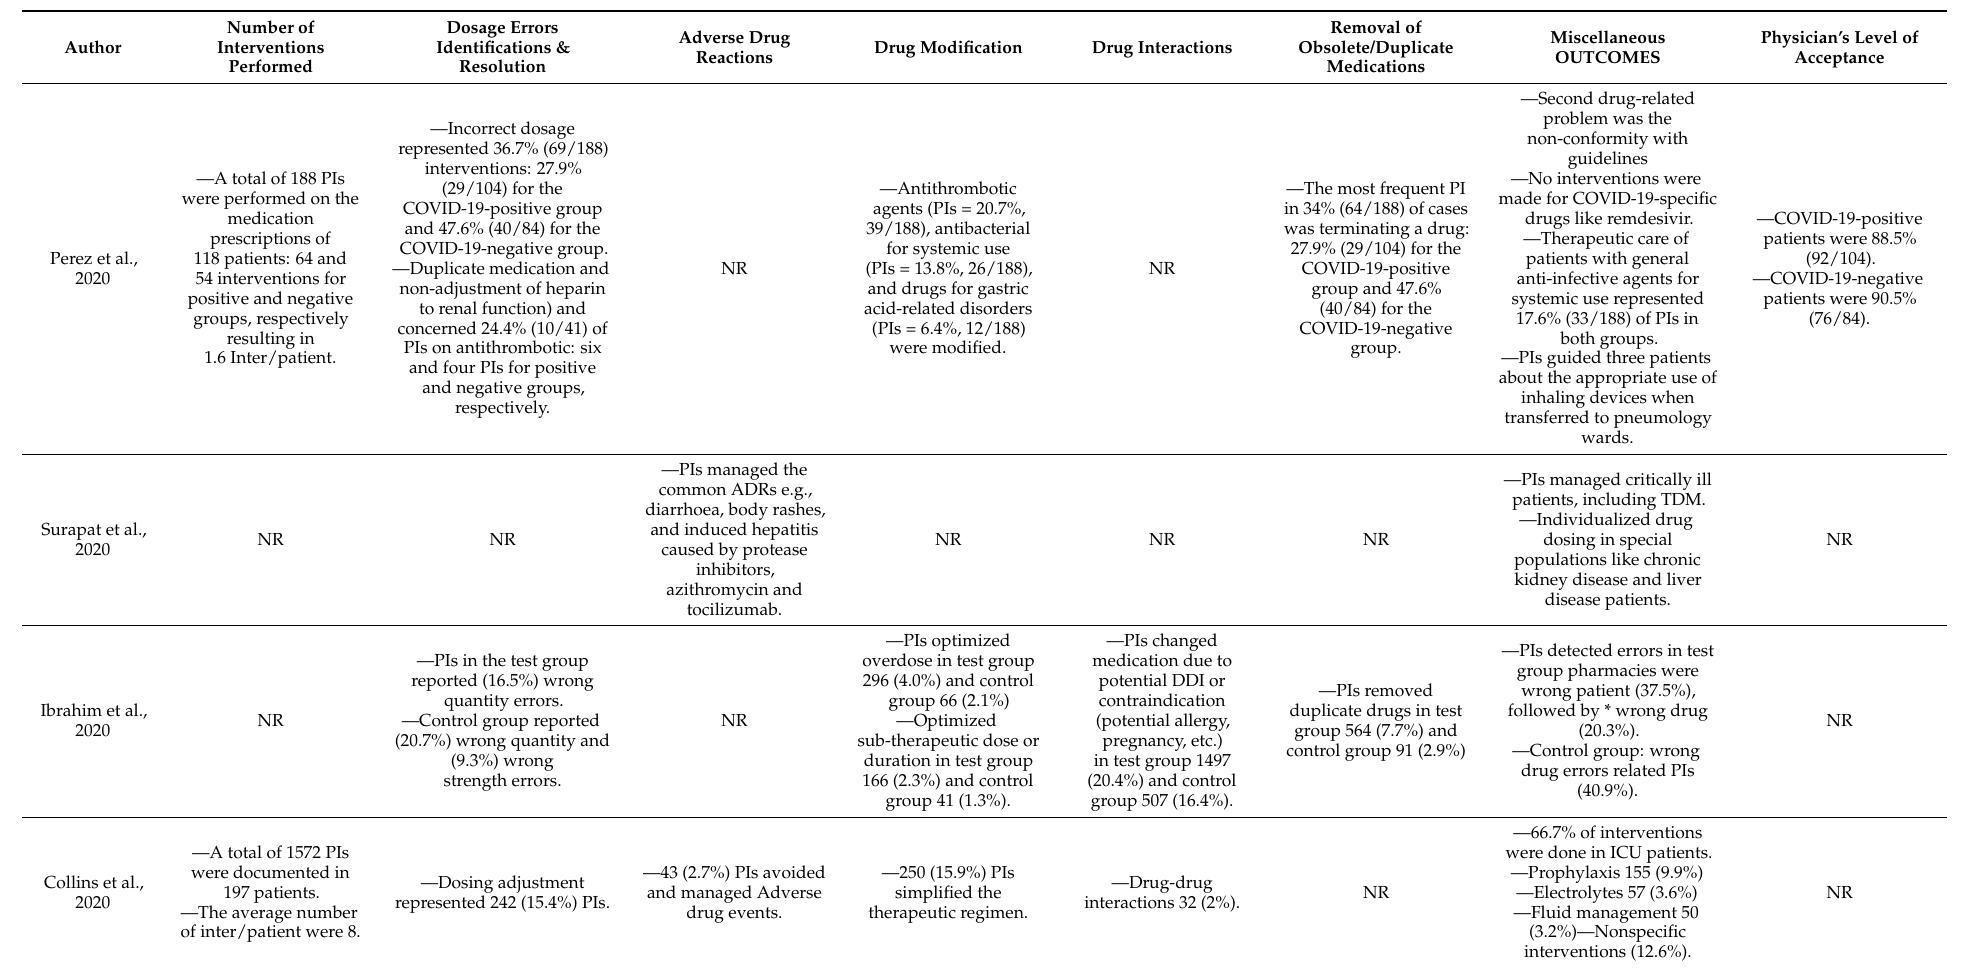
Table 3. Description of outcomes of pharmacist interventions reported in included